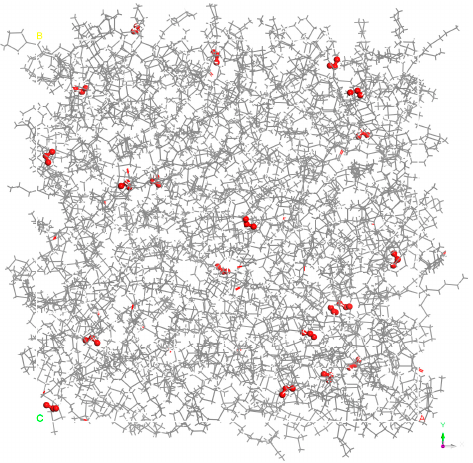
Figure 2. Amorphous multiple-molecules model of oil-water-acid system with 20 stearic acid (SA) molecules at 343K.